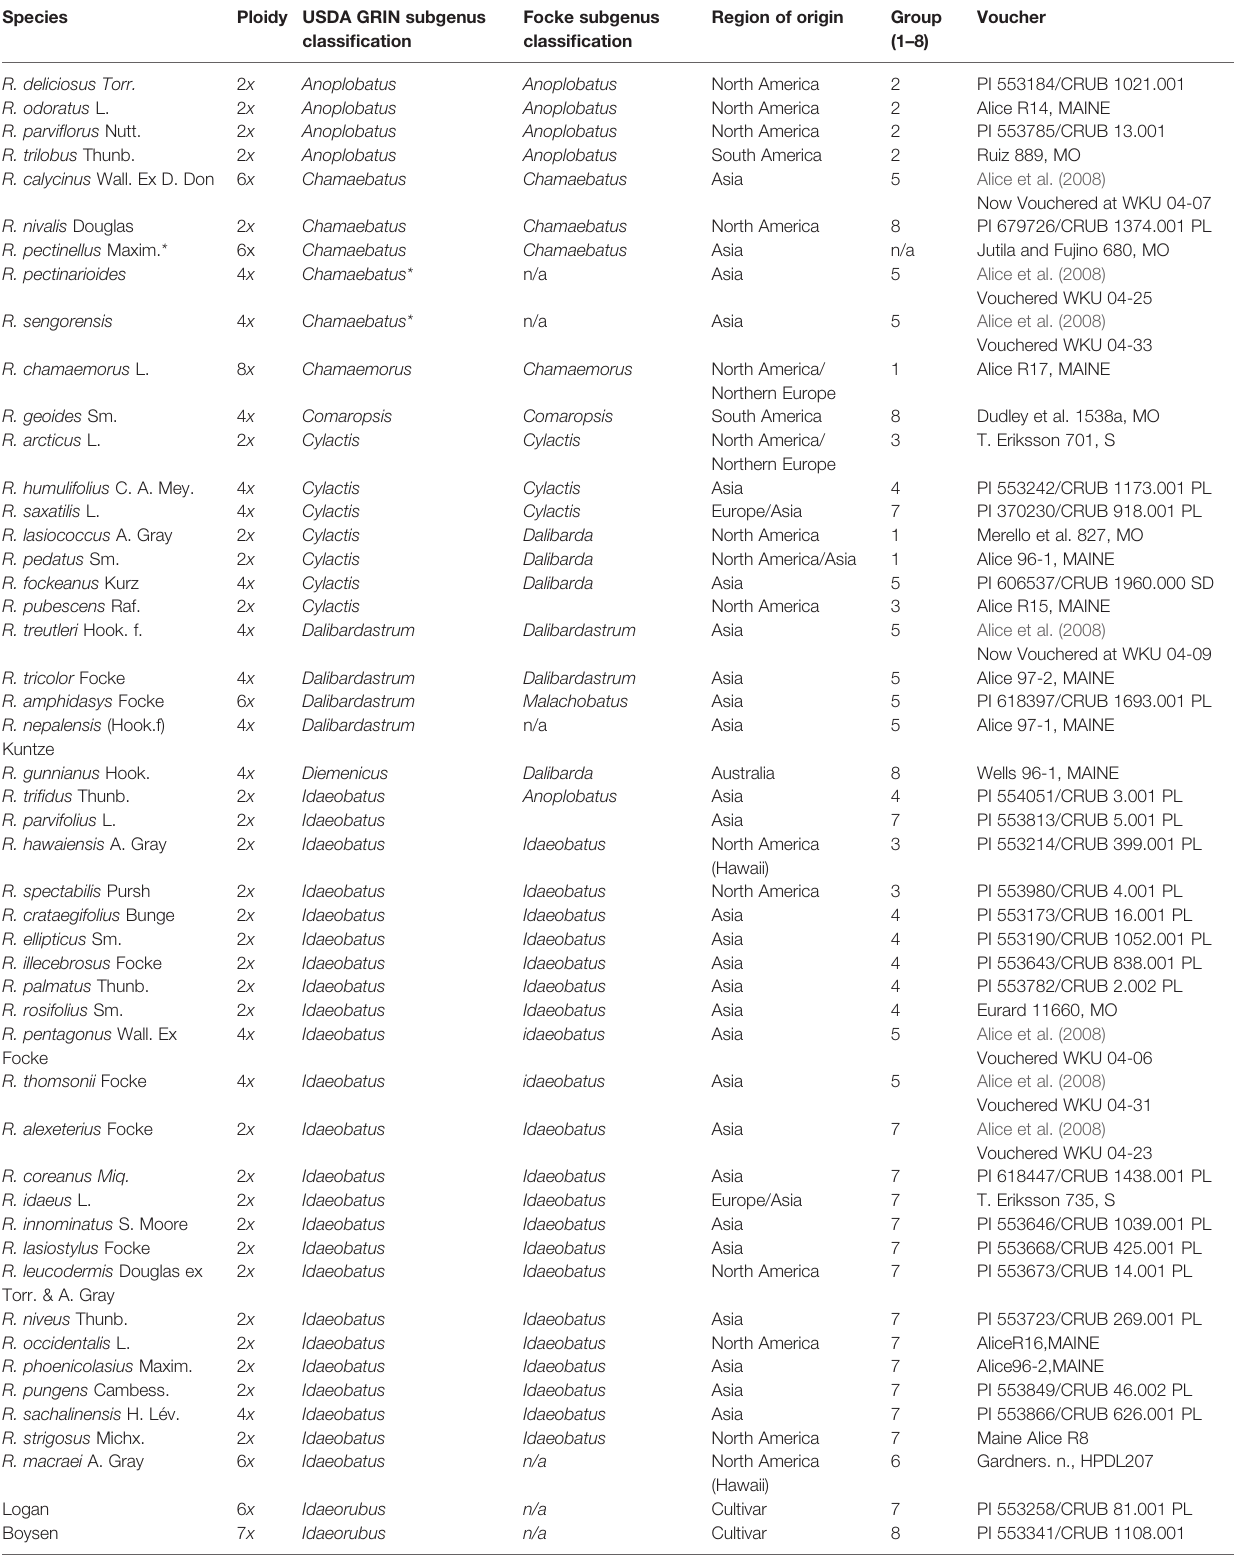
TABLE 1 | Accessions of Rubus species and outgroup ( Waldsteinia fragarioides ) used in this